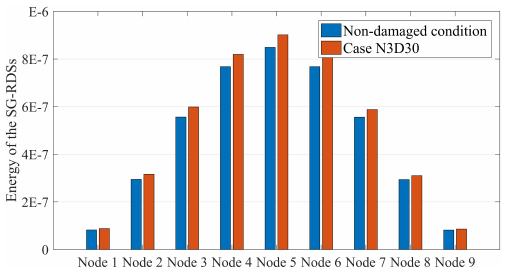
Figure 7. Distribution pattern of energy of SG-RDSs along a simply supported beam subjected to moving sprung mass with speed 2.5 m/s. The blue bars are a non-damaged condition. The orange bars are the damaged condition for case N 3 D